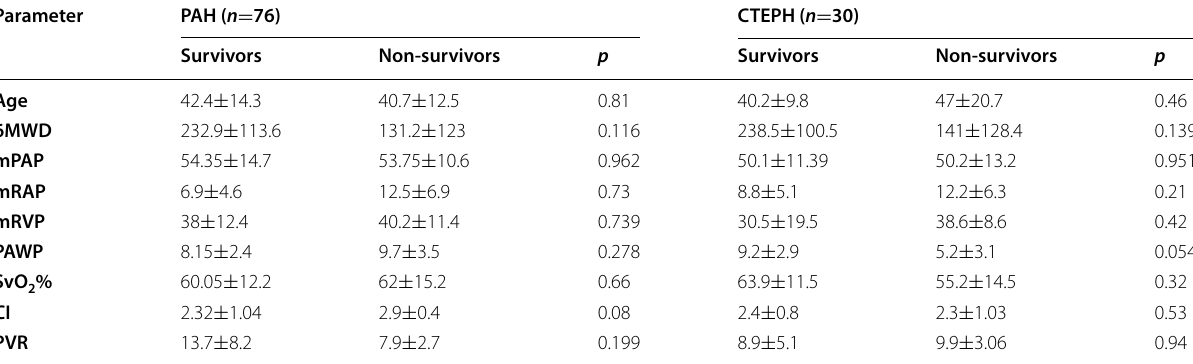
Age in years. Distance in meters. Pressures in mmHg. CI in liters/minute/meter 2 . PVRI in Wood units.meter 2 Continuous data expressed as mean standard deviation ± PAH pulmonary arterial hypertension, CTEPH chronic thrombo-embolic pulmonary hypertension, 6MWD 6-minute walk distance, mPAP mean pulmonary artery pressure, mRAP mean right atrial pressure, mRVP mean right ventricular pressure, PAWP pulmonary artery wedge pressure, SvO 2 systemic mixed venous